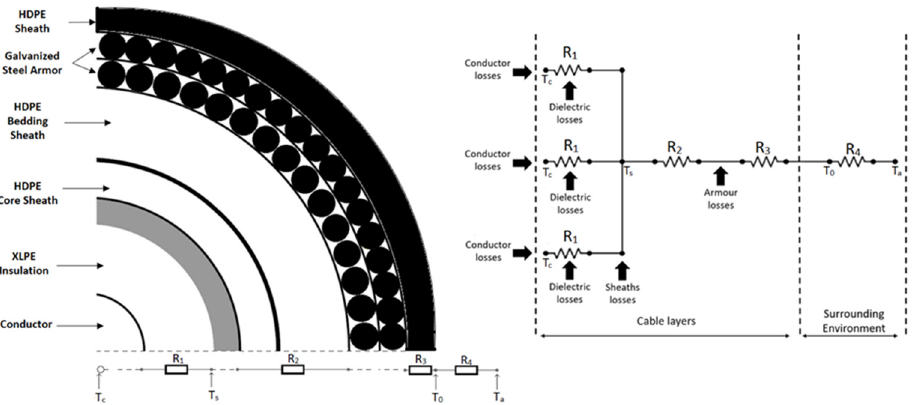
Figure 13. Network of thermal resistances representing steady state heat transfer in a three core submarine cable and its surrounding